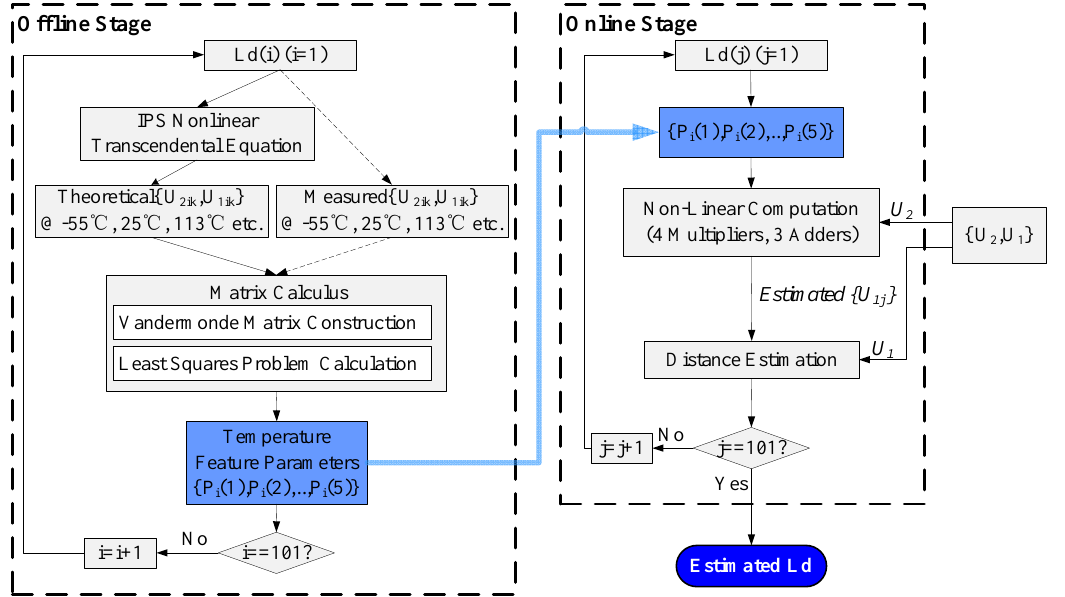
Figure 5. Block diagram of the dual-stage scheme (the offline stage performs a large amount of computation and generates the temperature feature parameters, while the online stage predicts the target distance based on a non-linear piecewise fitting scheme with these